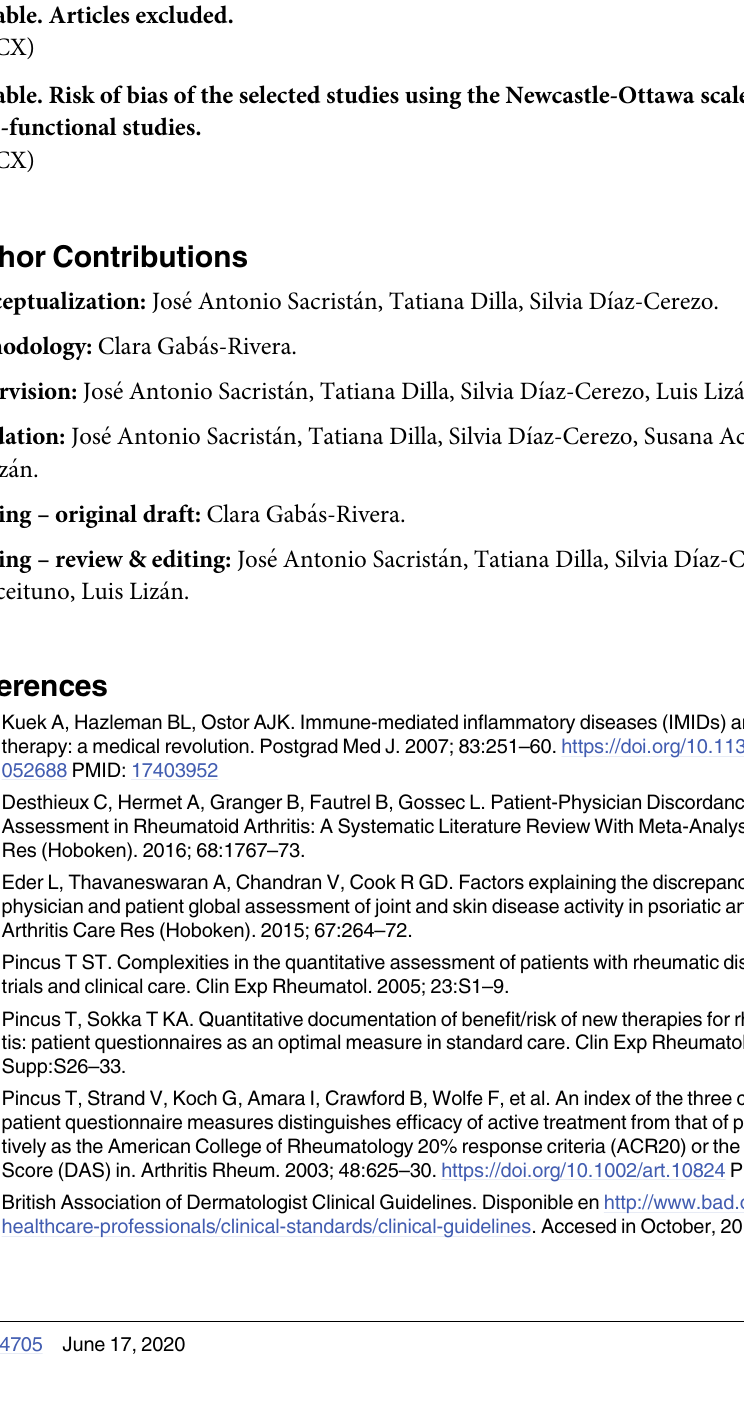
reviews. S1 Table. Terms and search strategy in international and Spanish databases. S2 Table. Discrepancy and predictor factors in immune-mediated inflammatory diseases (RA, PsA and Ps). S3 Table. Articles excluded. S4 Table. Risk of bias of the selected studies using the Newcastle-Ottawa scale, adapted for cross-functional